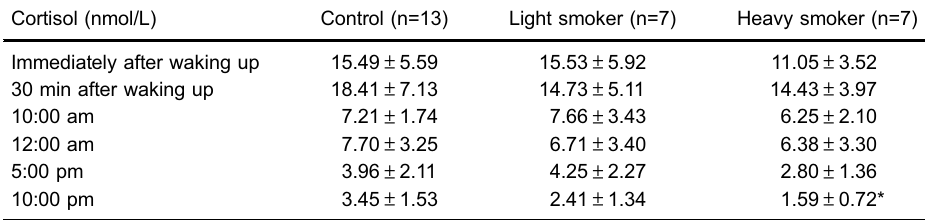
Data are reported as means ± SD. *P=0.02 compared with control group